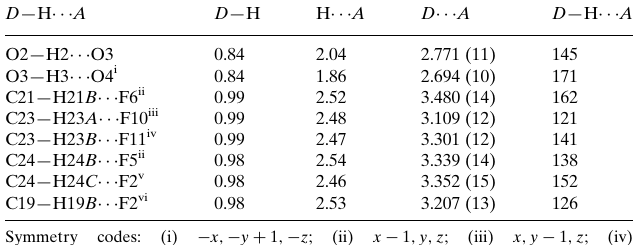
Hydrogen-bond geometry (A˚ , (cid:3) ). D —H (cid:2)(cid:2)(cid:2)